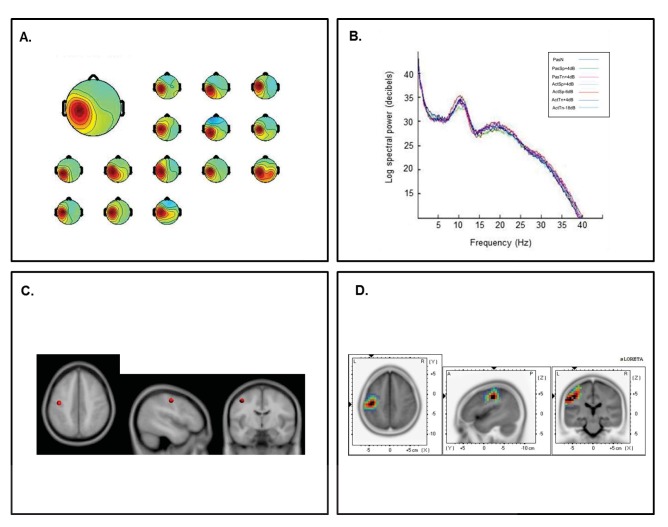
Cluster results for the left-hemisphere µ component.A) mean scalp potential distribution (W−1) scaled to RMS microvolts and individual scalp distributions for each participant, B) mean spectra of the component as a function of condition, C) average equivalent current dipole location, and D) maximum current source density voxels (t-values) with greater values in darker colors and smaller values in lighter colors (NIH Micro template) (at p<.001 corrected for multiple comparisons).